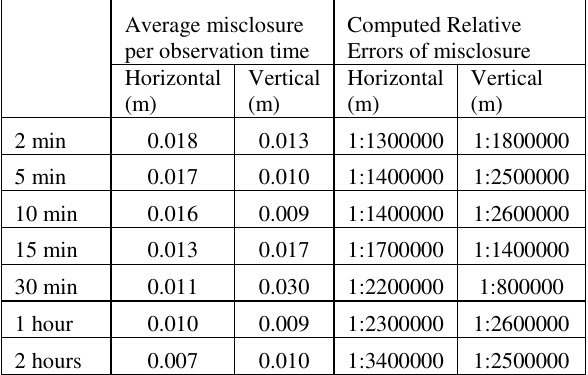
Table 6. Average misclosures and relative precisions of GNSS observations for all durations .